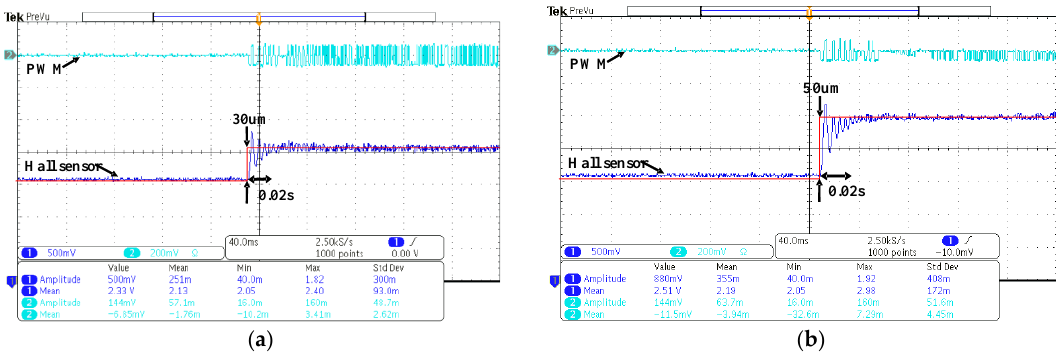
Figure 10. Experimental results of step responses with the designed controller applied to the OIS along x -direction; ( a ) Step command of 30 μm; ( b ) Step command of 50 μm.